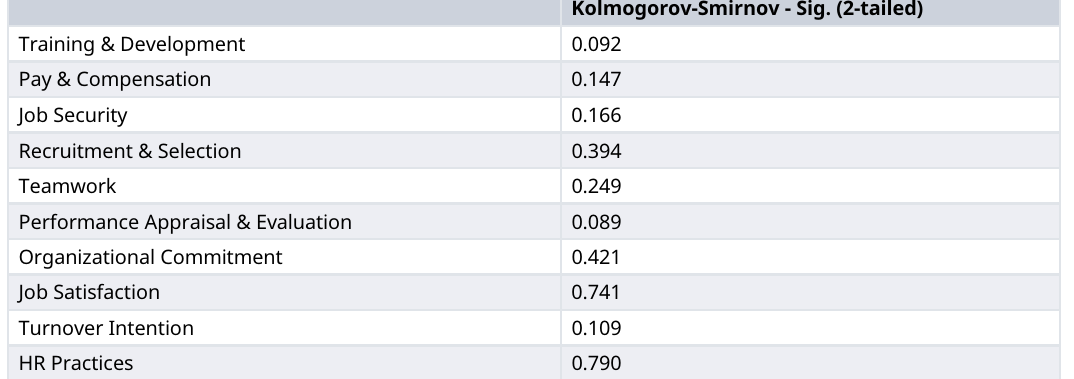
Table 2. Tests of